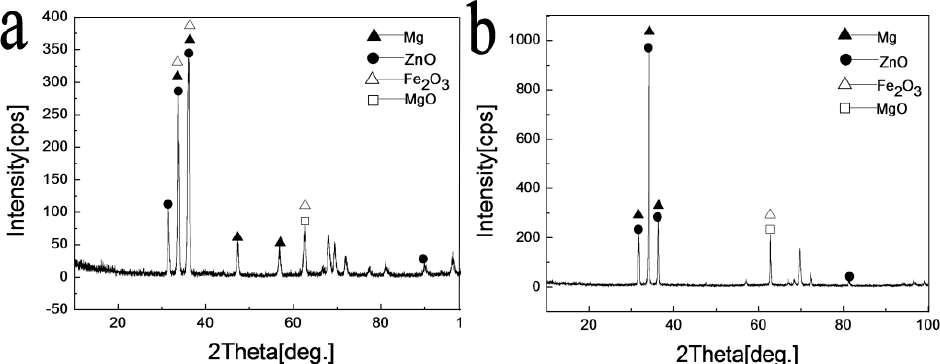
Figure 9. The analysis of X-ray Diffraction (XRD) experimentation using two methods: ( a ) Mg99.50/DP600 FSKSW; and ( b ) Mg99.50/DP600 VDW.